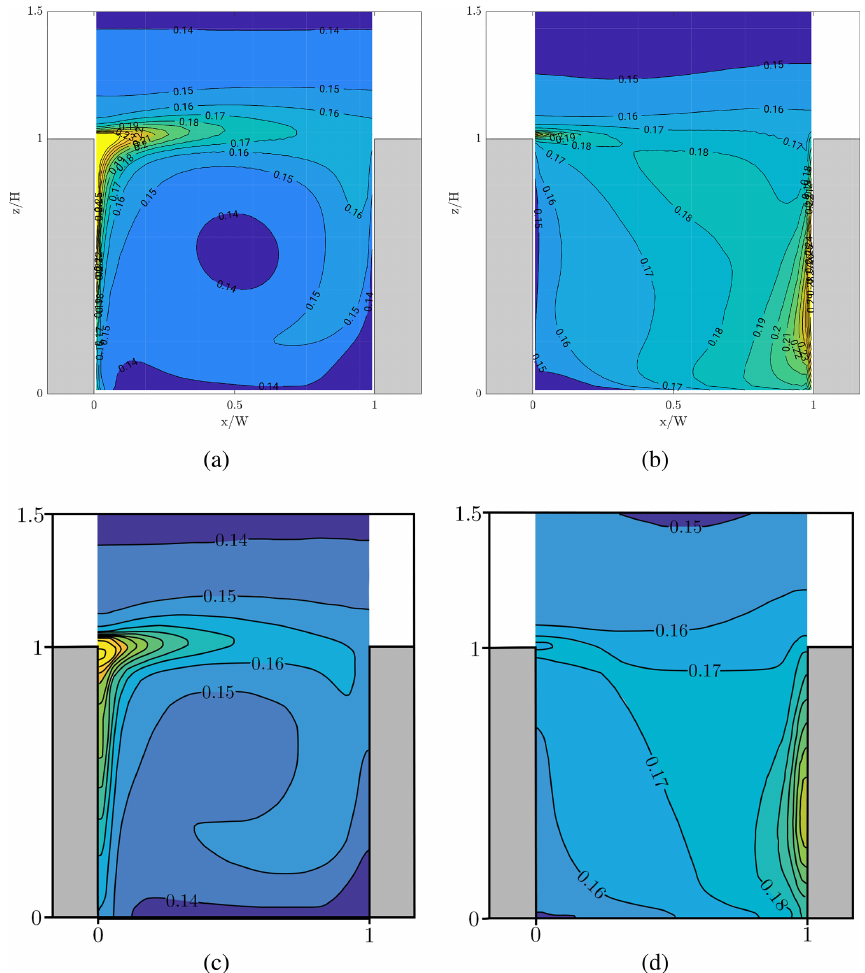
Figure 2. Mean temperature fields (a, b) compared to results reproduced from Cai (2012a, c , d ). In all cases, T 0 was subtracted. The left column shows the assisting case and the right column the opposing